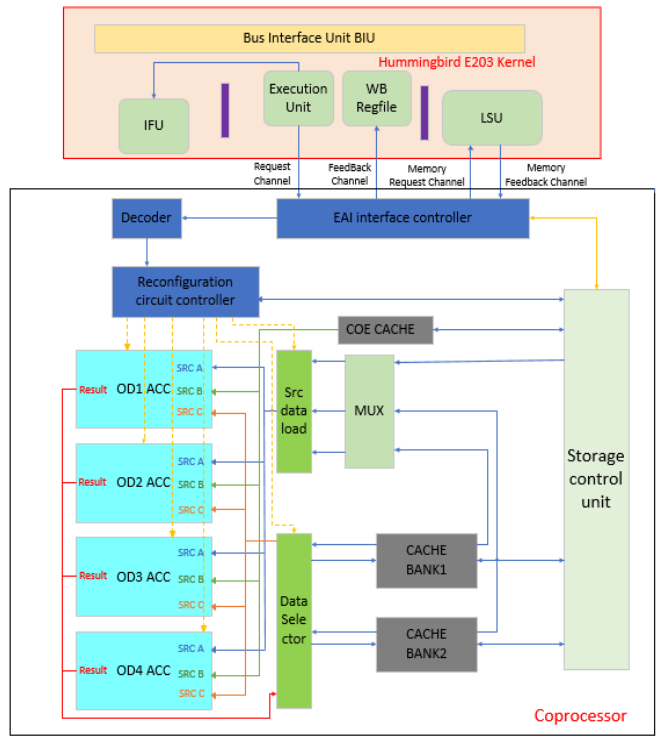
Figure 4. Hardware architecture of the accelerated coprocessor for object detection.